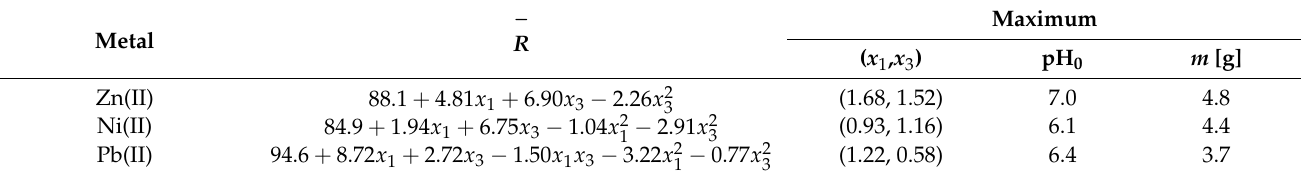
Table 6. The results of optimization of the adsorption